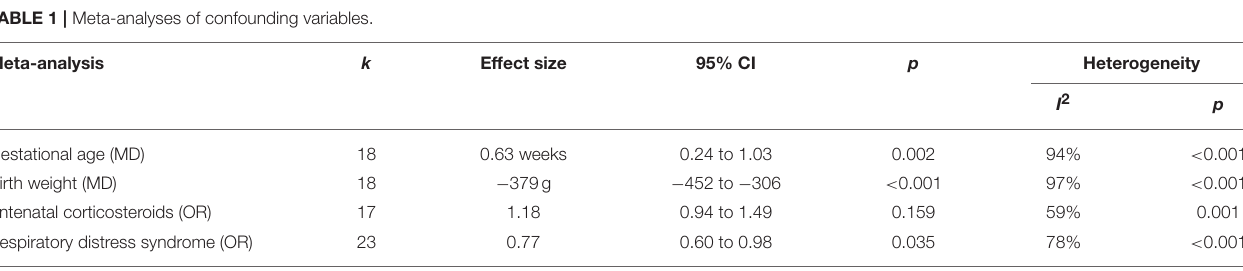
TABLE 1 | Meta-analyses of confounding